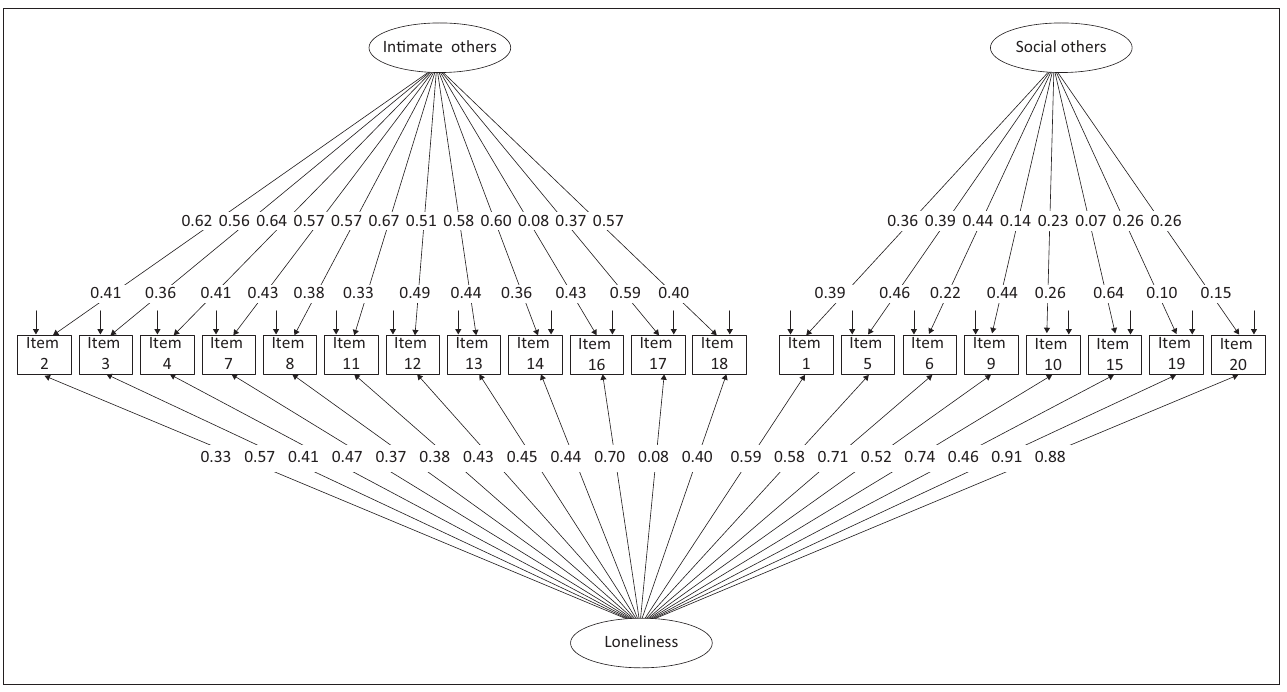
FIGURE 3: Bifactor model of UCLA-LS3: Two subscales.